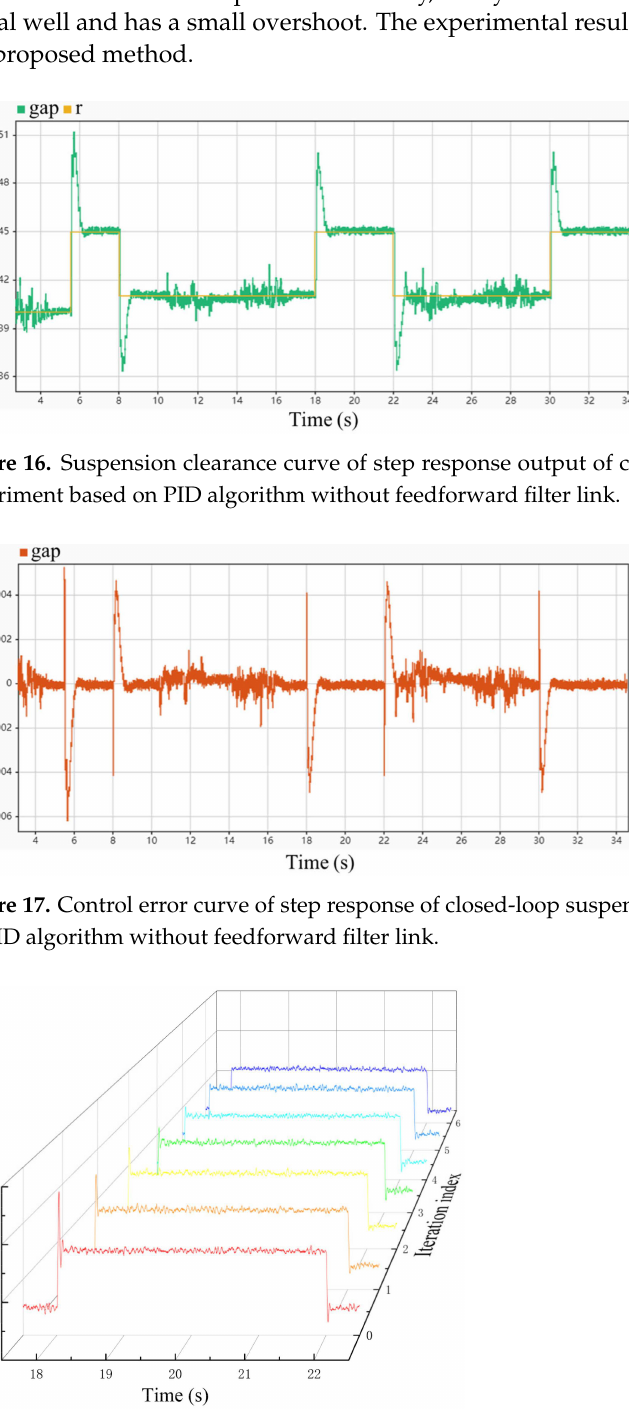
Figure 18. Suspension gap curve of step response output of suspension control experiment based on time driven nonlinear iterative inversion with feedforward filter